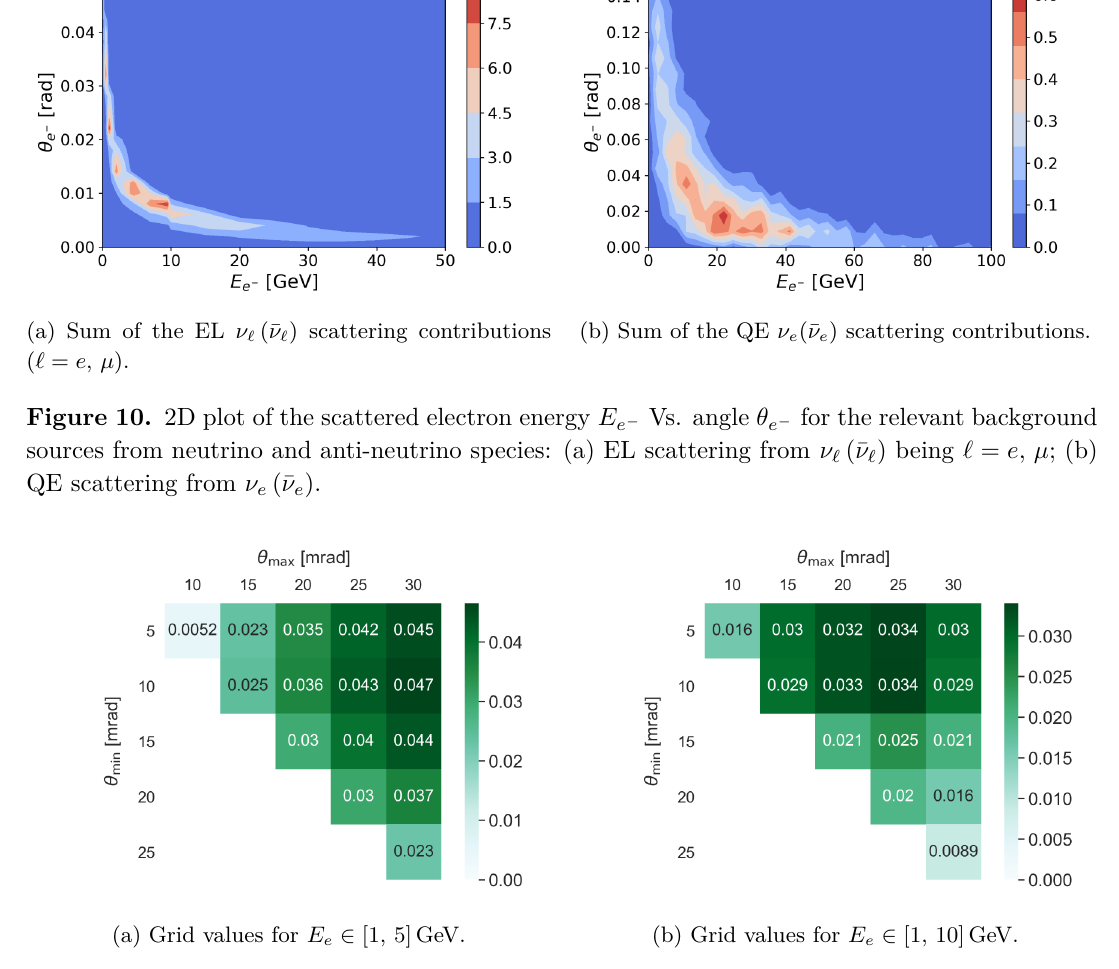
Figure 11. Grid-search optimisation of the significance Σ as a function of the angular cut for a fixed energy window. The left axis represents the lower cut value for θ is the higher one. The plots in the two panels share the same normalisation. The best selection corresponds to the tighter energy window (a) and the angular range [10 , 30]